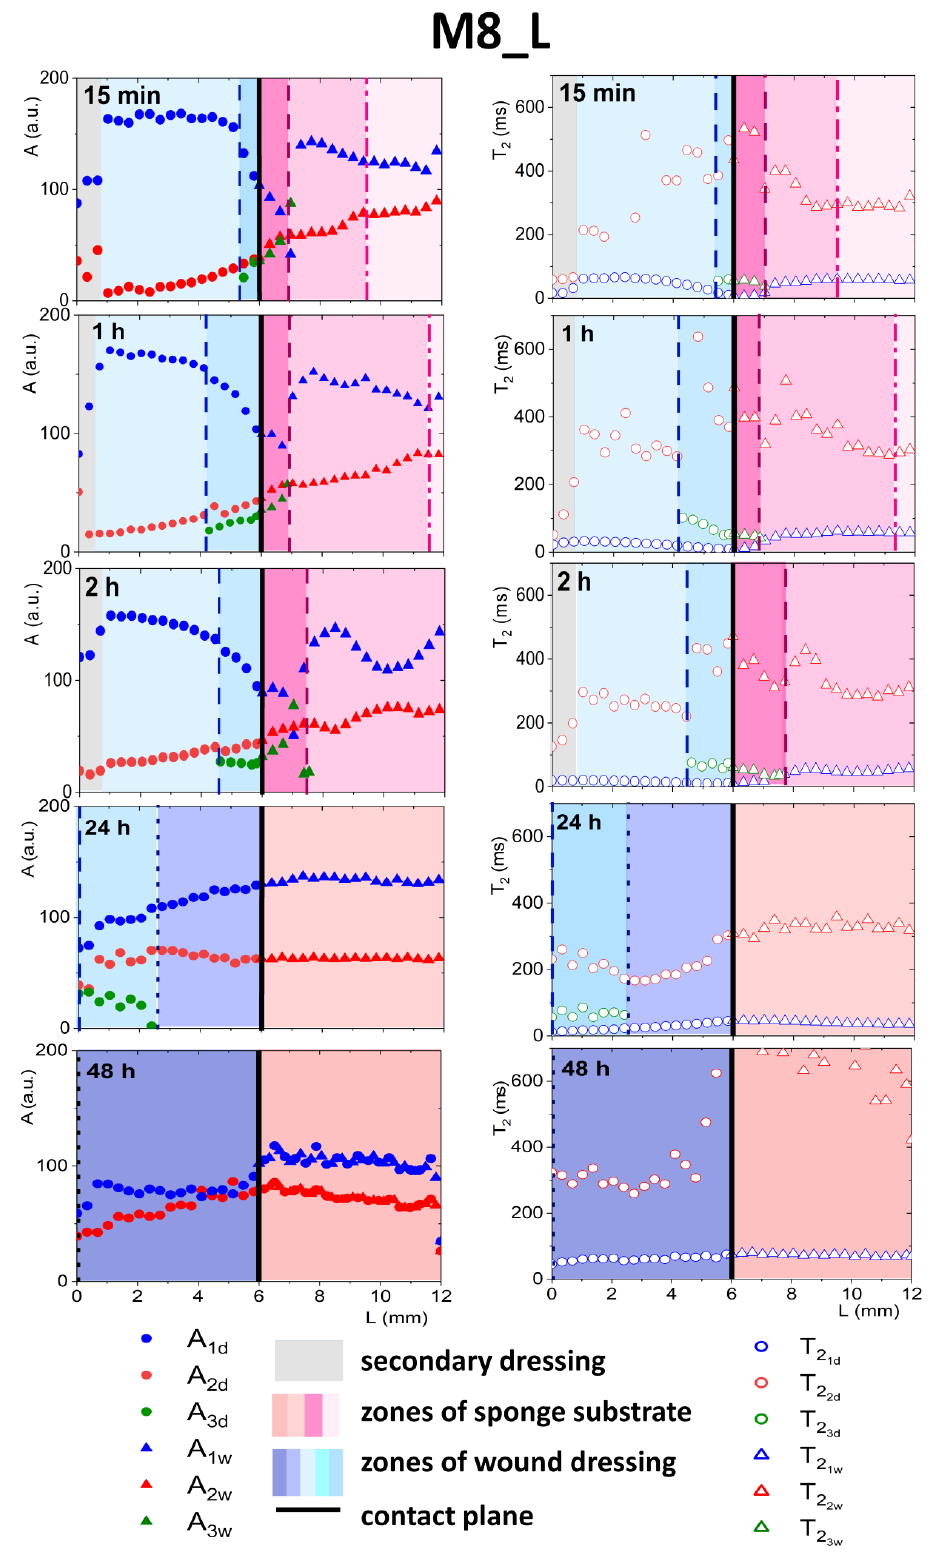
Figure 7. Parameter profiles obtained by MRI, relaxation time ( T 2 ) or signal amplitude ( A ), for M8_L for the whole in vitro wound dressing stack model, when the sponge medium solution was PG.